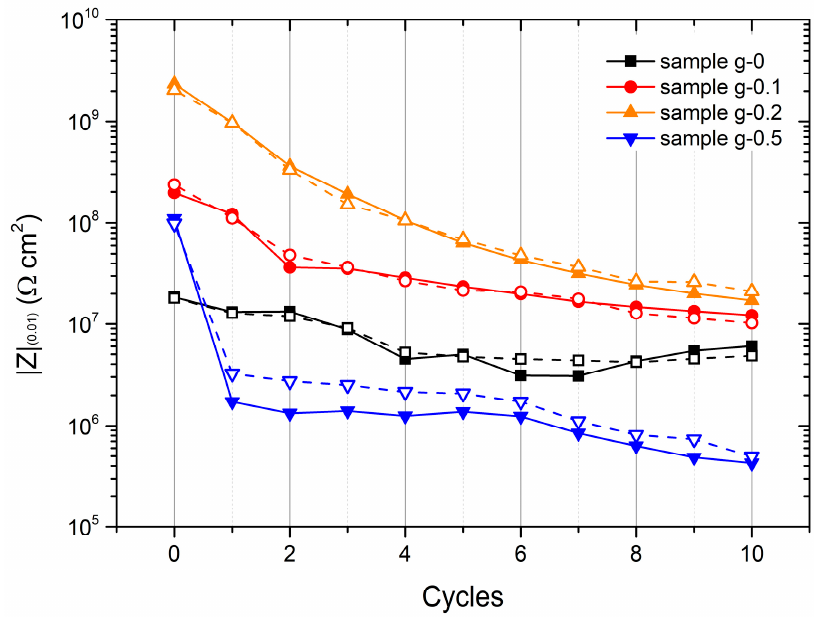
Figure 4. Evolution of the Bode modulus | Z | (0.01) during the AC–DC–AC cycles. Solid and dashed lines represent replicates of the same series of samples.